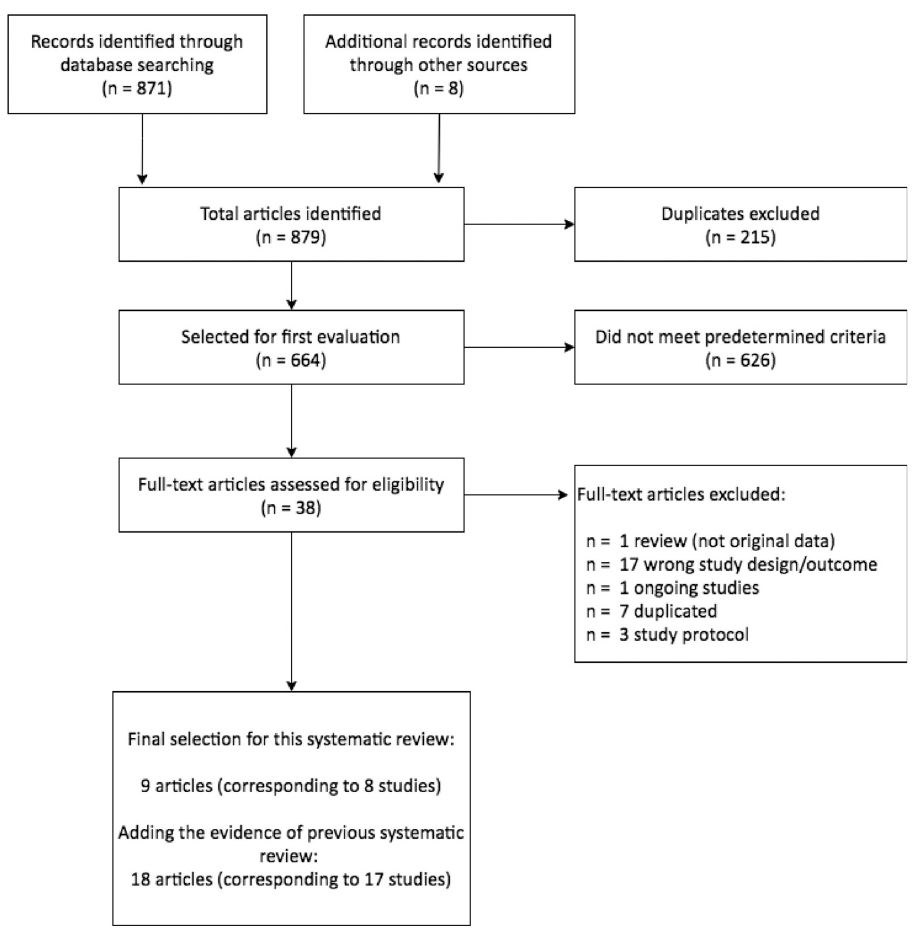
Fig 1. Flow diagram for selected